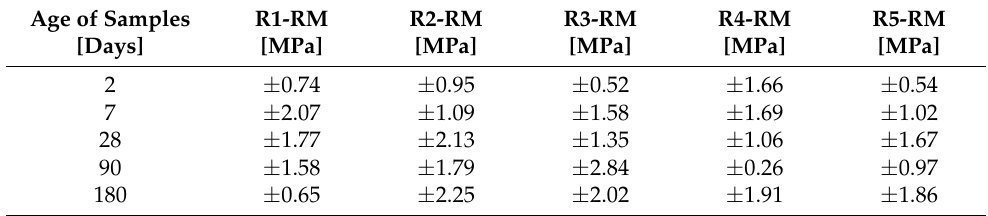
Table 8. Standard deviation values during the measurements of compressive strength